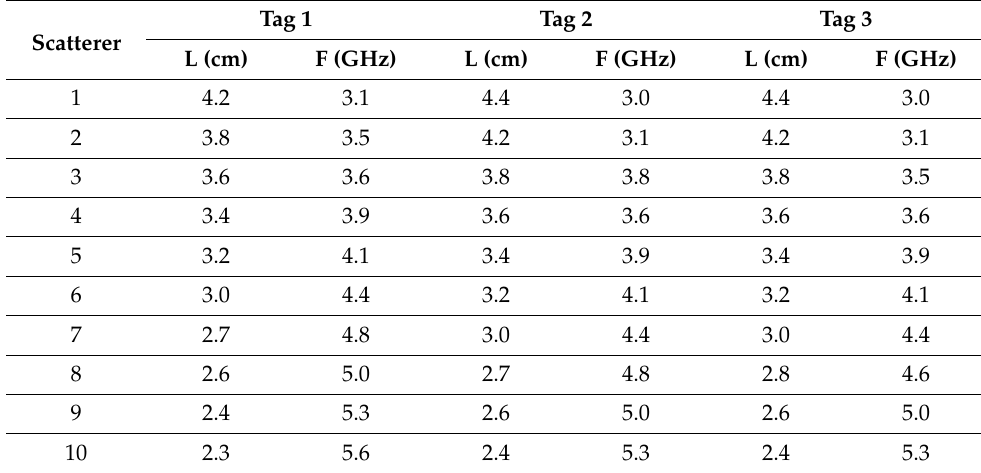
Table 1. Length and resonant frequencies of 10 scatterers for three tags.